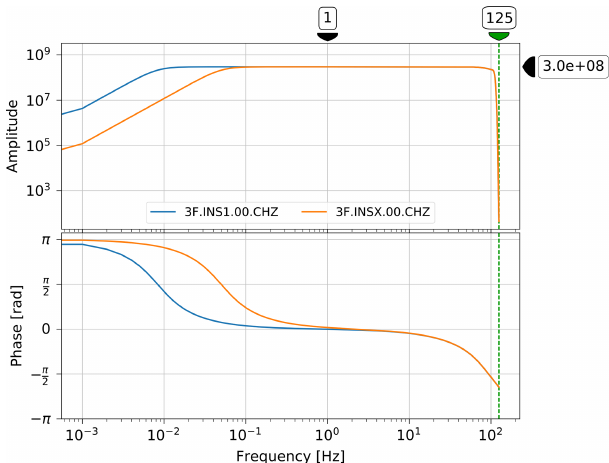
Figure 2. Amplitude and phase response curves for the INS1 station (blue curves), equipped with a 0.0083–100Hz TCPH seismometer, and for the INSX station (orange curves), equipped with a 0.05– 100Hz TCPH seismometer. The sensor sensitivity at 1Hz is also reported. The vertical dotted green line indicates the Nyquist fre- quency of